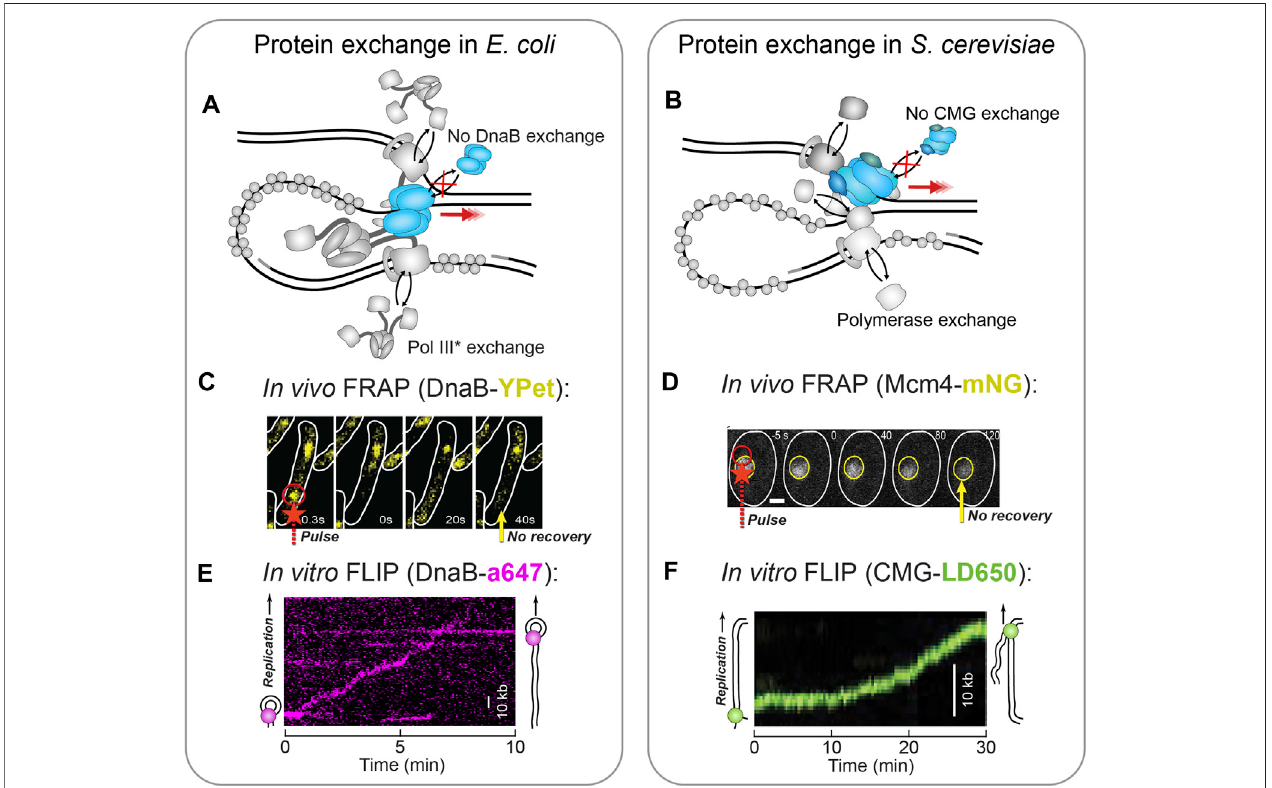
FIGURE7|Single-molecule fl uorescencevisualizationofreplisomestability.(A) Inthe E.coli replisome,thepolymeraseholoenzyme(polymerasecoreand clamploadercomplex)hasbeenshowntoexchangerapidlyduringreplication(Beattieetal.,2017;Lewisetal.,2017),whiletheDnaBhelicaseremainsstablyassociated (Spinksetal.,2021). (B) Inthe S.cerevisiae replisome,eachofthepolymerasesdemonstratessomedegreeofexchange,whiletheCMGhelicaseshowsacompletelack of exchange (Kapadia et al., 2020; Lewis et al., 2020). (C) In vivo FRAP applied to fl uorescent DnaB-YPet shows no recovery (yellow arrow) after the FRAP pulse (redarrow)andthusno exchange (Beattie etal.,2017). (D) Invivo FRAPapplied to fl uorescent Mcm4-mNG aspartofCMGshowsnorecovery(yellowarrow)inthearea bleached by the FRAP pulse (red arrow) (Kapadia et al., 2020). Therefore, CMG does not exchange. (E) In vitro FLIP applied to fl uorescent DnaB-a647 within single- molecule rolling-circle replication. In this example kymograph the DnaB signal persists even though it is challenged with extra unlabeled DnaB, and therefore is not exchanging(Spinksetal.,2021). (F) Invitro FLIPappliedto fl uorescentCMG-LD650duringsingle-moleculereplicationofalinearDNAtemplate.TheCMGsignalpersists even though it is challenged with excess unlabeled CMG, and thus does not exchange (Lewis et al.,